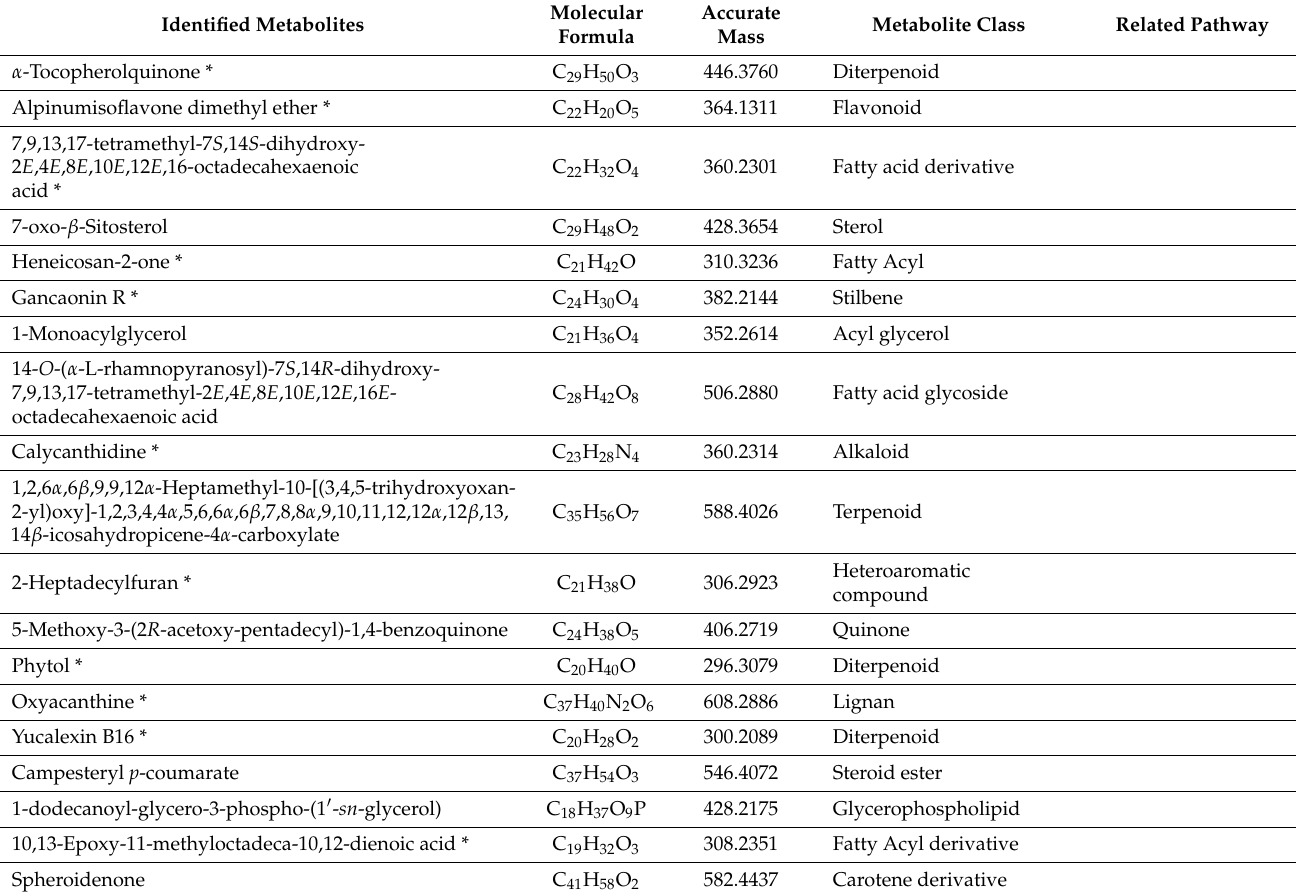
Figure 2. Venn diagram showing the common compounds among the three extracts ( n = 33), and the common compounds among the most active extracts (hexane and CHCl 3 /MeOH, n = 80). Table 1. Common compounds identified in the hexane and CHCl 3 /MeOH extracts (UHPLC-QTOF-MS/MS)- and metabolomic pathways.